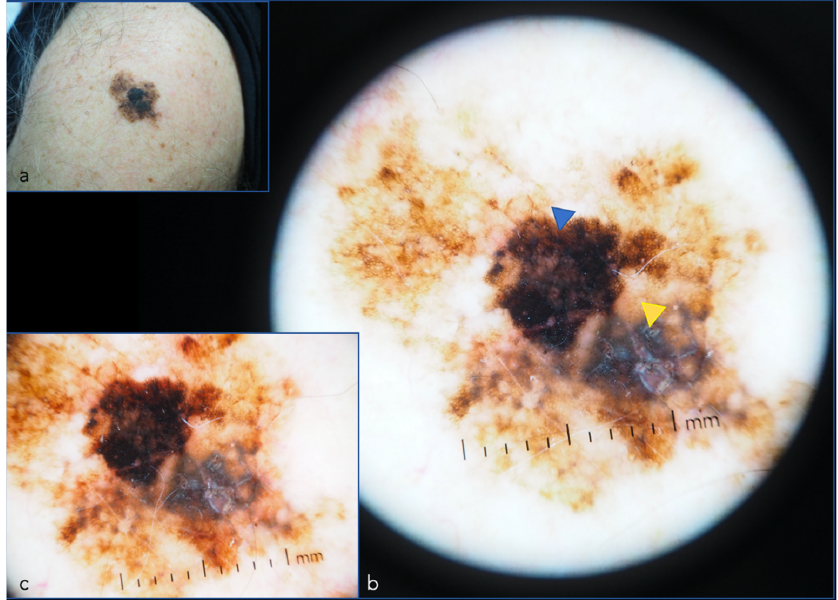
Figure 6. Melanoma in situ (left arm): ( a ) Clinic picture; ( b ) Dermoscopic image. Blue triangle: black structureless area. Yellow triangle: gray structureless area; ( c ) Dermoscopic detail of structureless areas.